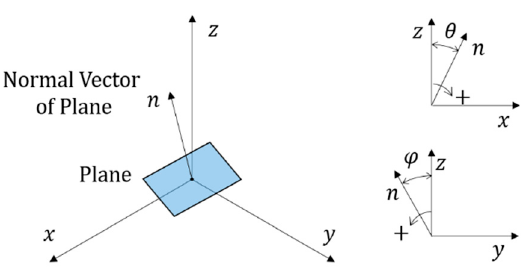
Figure 13. Refraction Model.